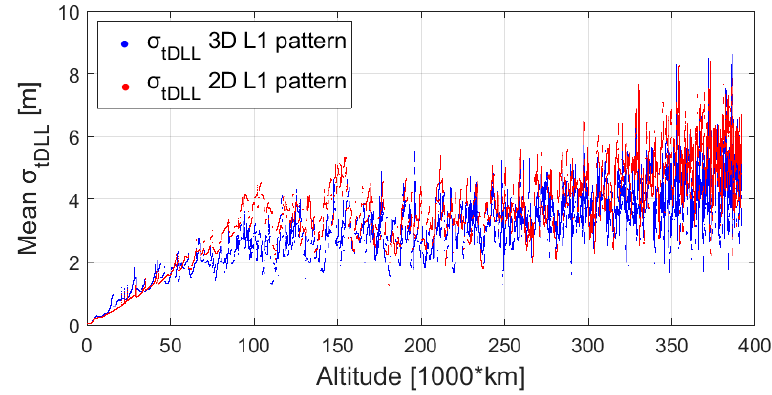
Figure 14. Mean code tracking thermal noise range error, for the assumed MTO. The thermal noise range error is computed for each available pseudo random noise (PRN) and the mean is plotted.